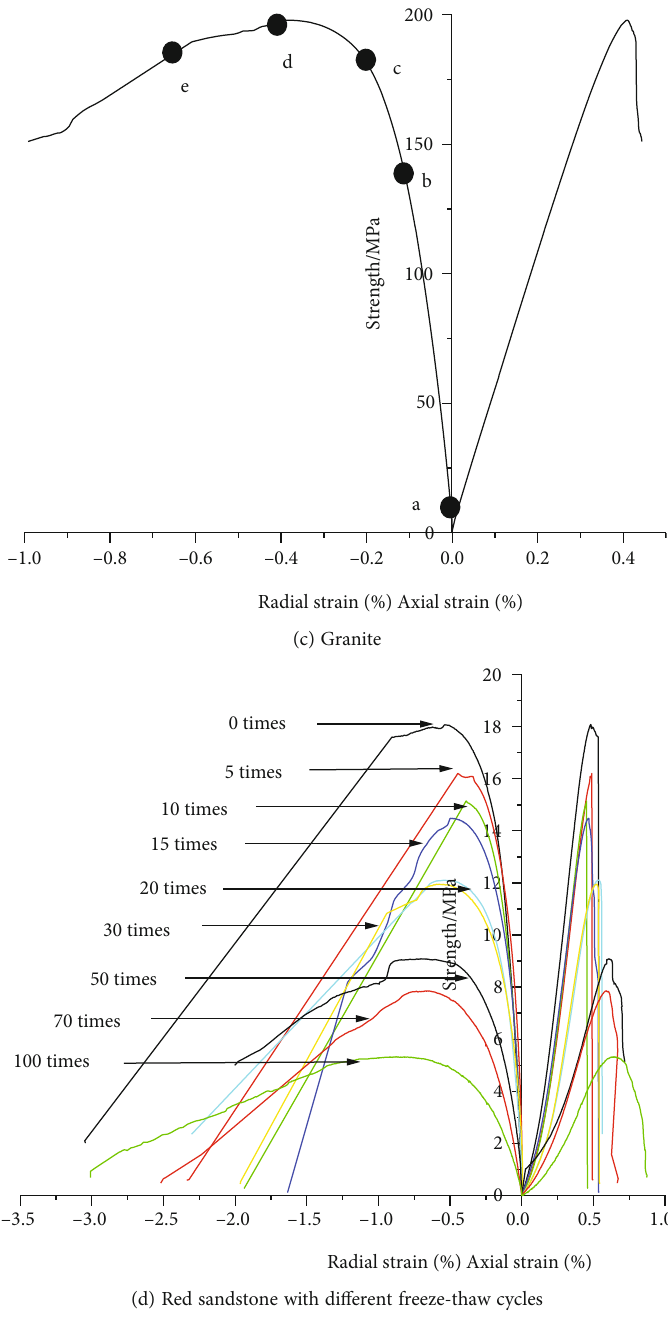
Figure 7: Stress-strain relationship of di ff erent